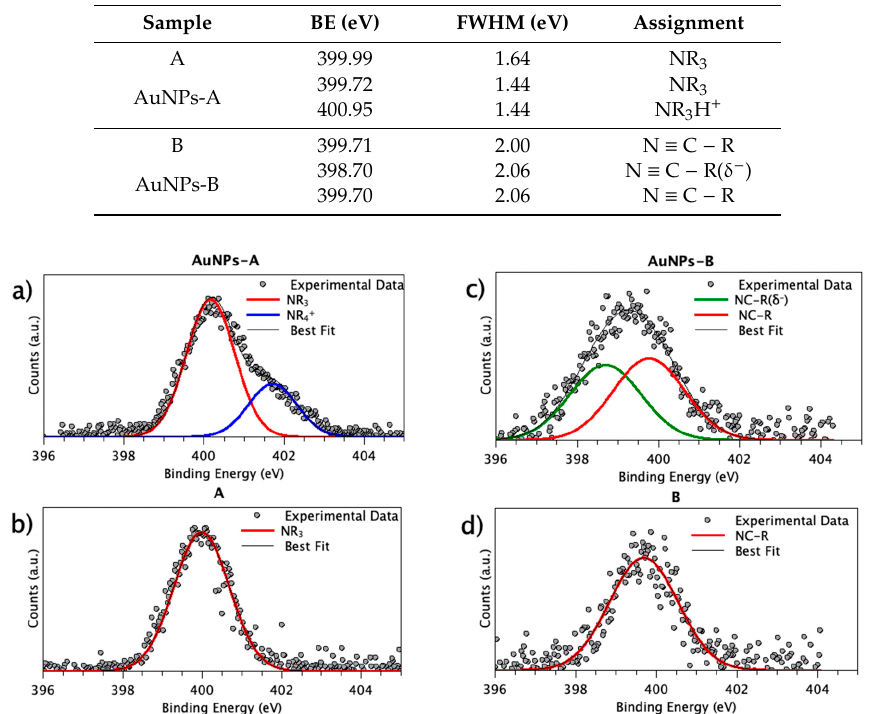
Table 1. N1s BE, FWHM values and assignments for pristine Cu(I) complexes and AuNPs carriers.